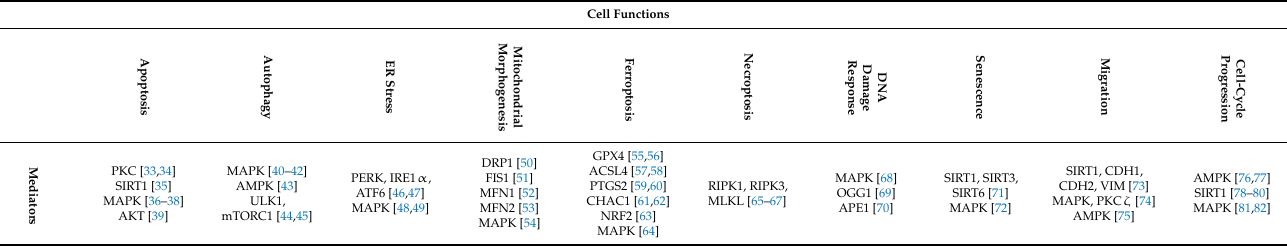
Table 1. Oxidative stress regulates cell functions via several